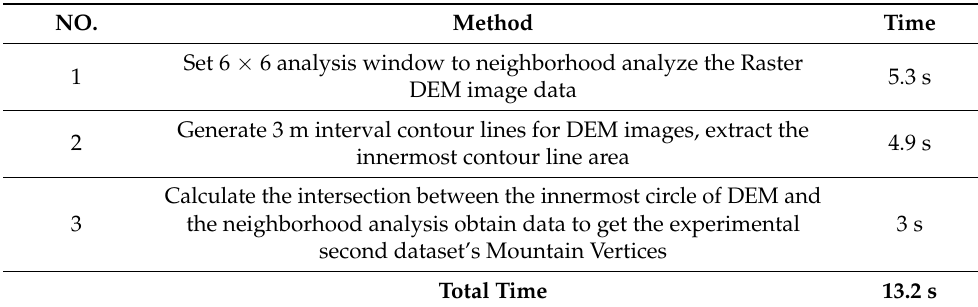
Table 9. The time spent in extracting mountain vertices for the second dataset using the Contour Line and Neighborhood Analysis Overlay Method.